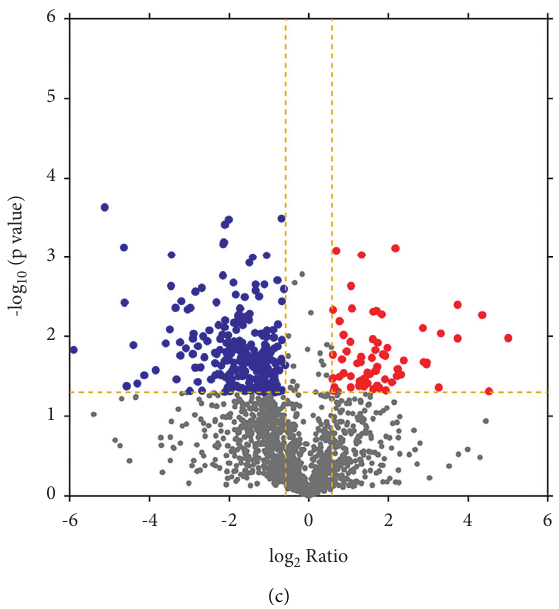
Figure 6: Volcano plot of the relative protein abundance changes in the annual branches of the three varieties of pitaya. (a) ZHL vs. XM, (b) ZHL vs. FL, and (c) FL vs. XM. The green and red dots are the up- and downregulated DEPs, respectively.